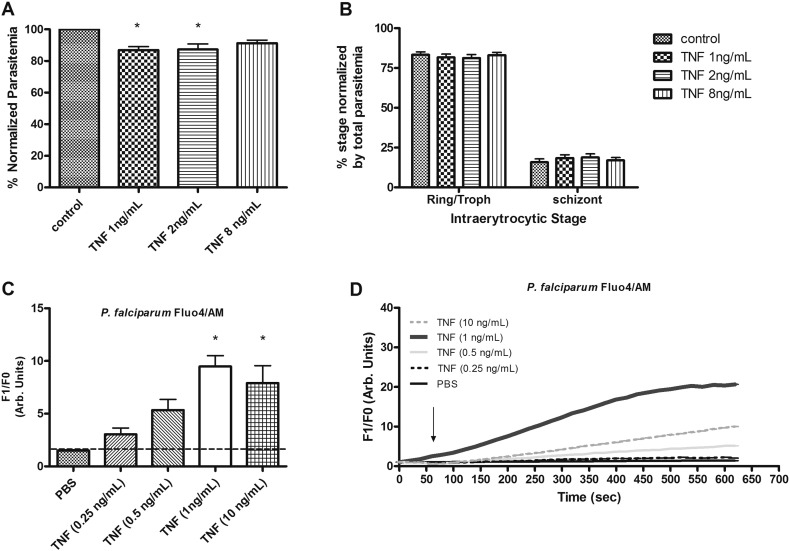
Effects of TNF on P. falciparum (3D7) erythrocyte invasion and Ca2 + concentration in isolated parasites. (A) Flow cytometry analyses of parasitemia in synchronized P. falciparum (3D7) after 48 h of control or TNF (1, 2 and 8 ng/ml) treatment (* P < 0.05) (B) and intra-erythrocytic stages distribution. Bars represent the number of parasites expressed as percentage of control or ring-trophozoites and schizonts (average) normalized by total parasitemia ± S.E.M. Cells were stained with dihydroethidine (5 μg/ml) and data (105 cells) were compared by one way ANOVA and by Newman–Keuls test. (C) Spectrofluorimetric analyses of Ca2 + concentration in isolated parasites labelled with Fluo4/AM (5 μM) after addition of TNF 0.25; 0.5; 1 or 10 ng/ml (3.05 a.u. ± 0.59, n = 11, P = 0.1536; 5.35 a.u. ± 1.01, n = 14, P = 0.064; 9.476 a.u. ± 1.03; n = 15, P = 0.001 and 7.91 a.u. ± 1.65, n = 10, P = 0.034, respectively). P values were calculated by comparison with the PBS data (1.505 a.u. ± 0.07, n = 4). Bar graph means and SEM of at least three independent experiments. Arb. arbitrary. (D) Representative tracing of Fluo4/AM changes over time by addition of TNF (0.25; 0.5; 1 and 10 ng/ml and PBS) in P. falciparum isolated parasites.